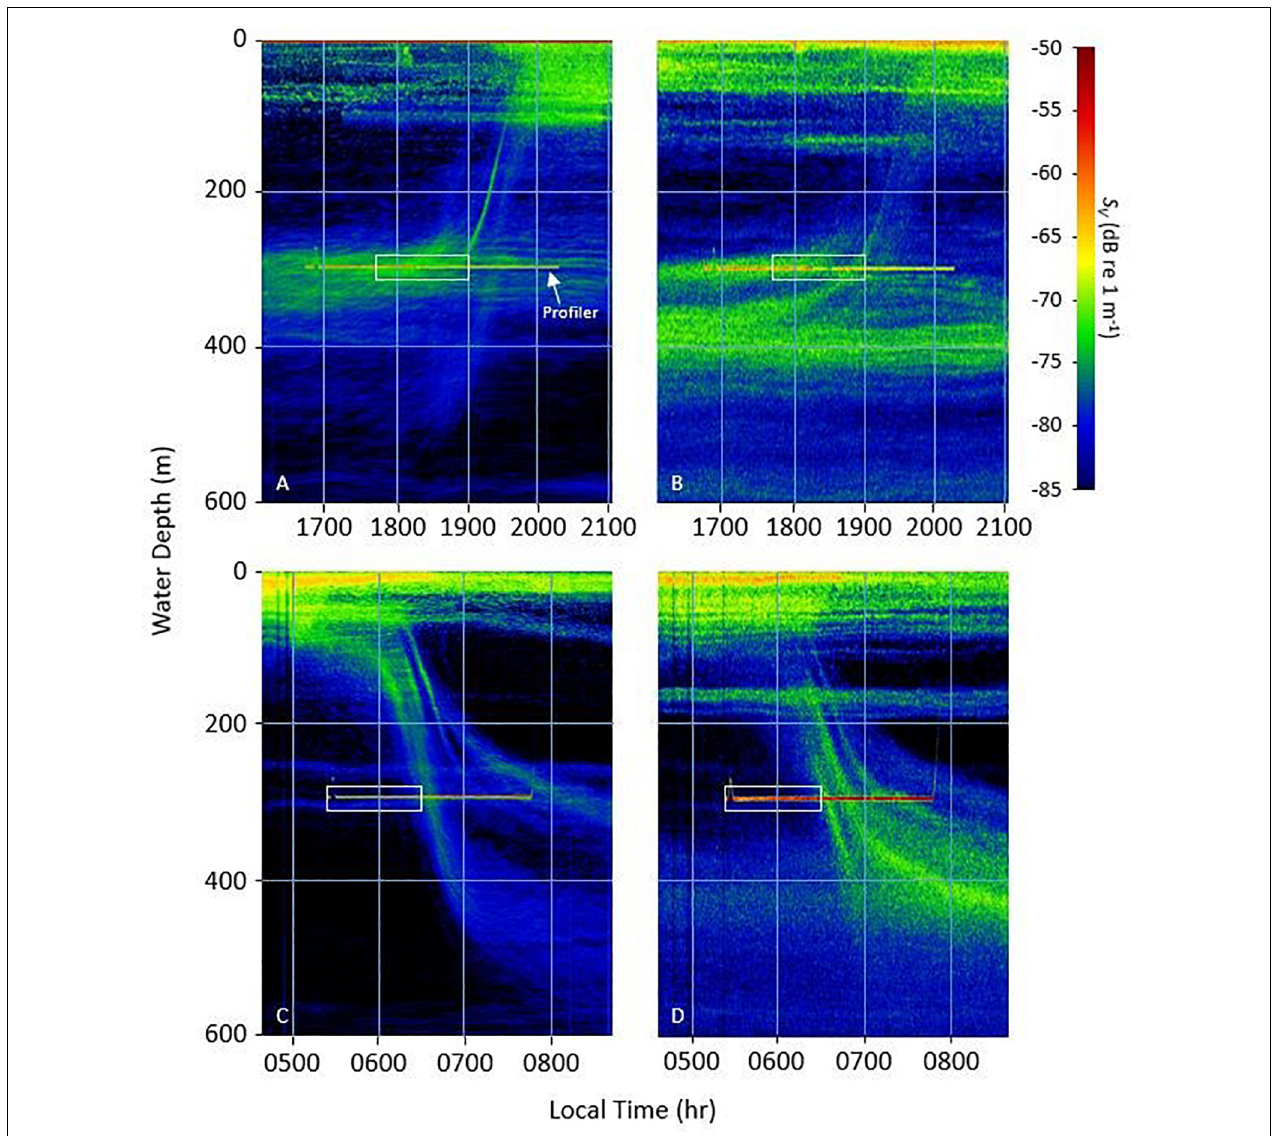
FIGURE 3 | Acoustic volume backscatter strength ( S V , dB re 1 m − 1 ) profiles derived from the shipboard EK-80 echosounder at 18 kHz (A,C) and 38 kHz (B,D) . Persistent backscatter at approximately 300 m is coincident with the position of the profiling package during full timeseries, while the white boxes represents the